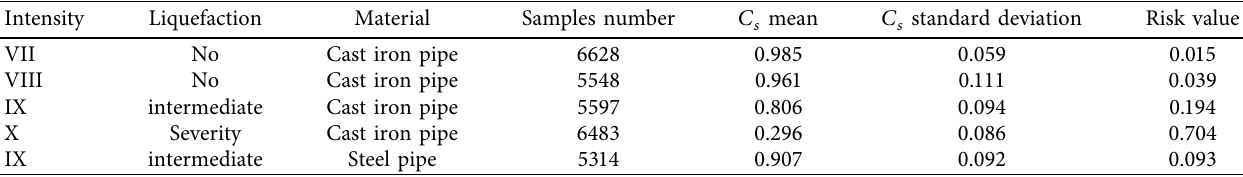
Figure 2: Schematic diagram of Apulian water supply network (spatial distribution). Table 3: Evaluation results of water supply rate of water supply network using different